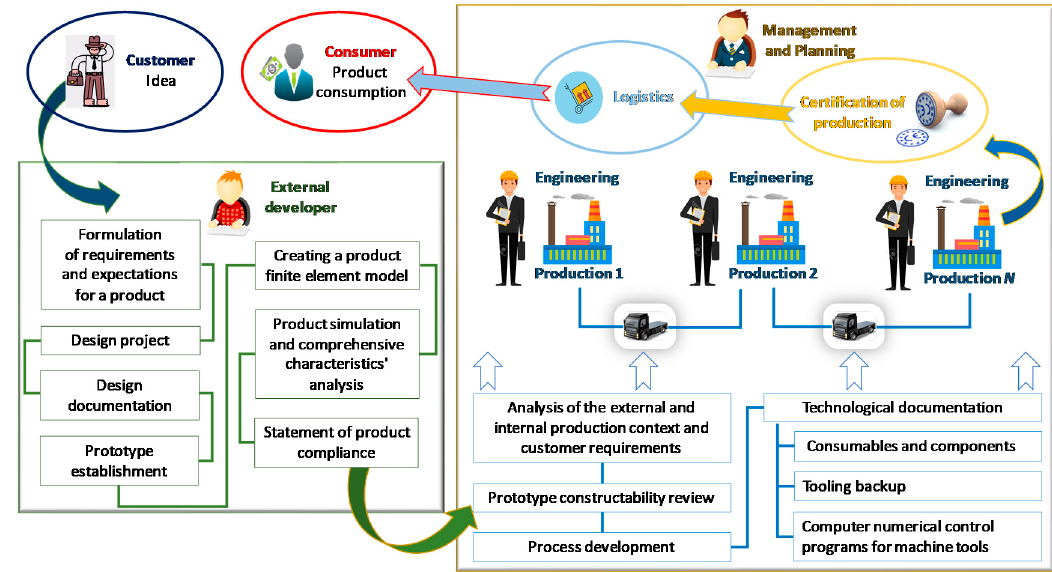
Figure 1. A modern conditional model of the concept implementation of introducing new non-food products from idea to final product.